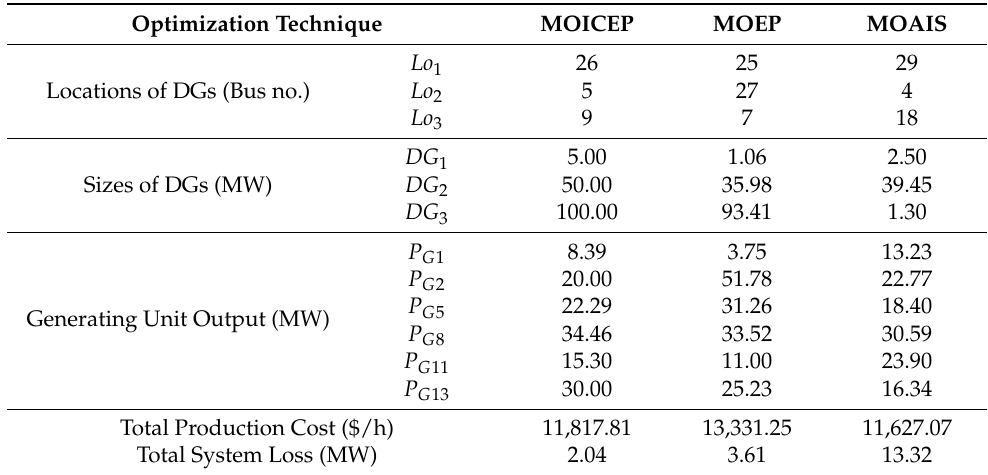
Table 16. Results of the integrated ED problem with a valve-point loading effect and DG installation of the IEEE 30-Bus RTS ( w 1 = 0.9 and w 2 = 0.1). Optimization